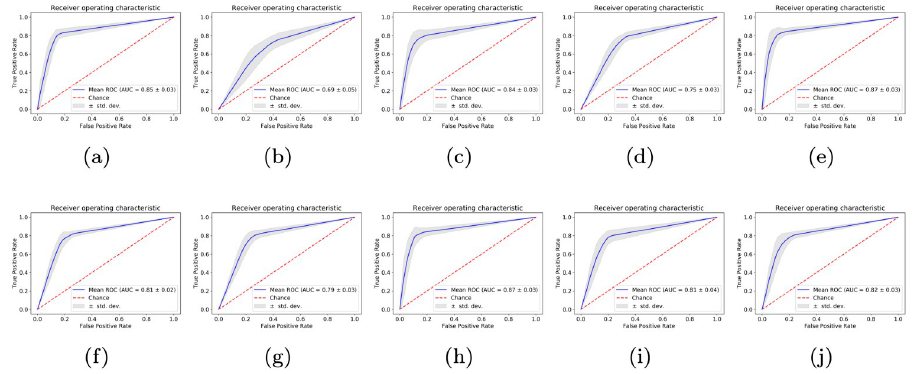
Fig 3. GBM signature in the DNA of blood-derived cells. ROC curves for pairwise classifiers built for comparing the mutation profiles of blood-derived DNA of GBM patients against (a) BLCA (b) HNSC (c) LUAD (d) LUSC (e) PAAD (f) PRAD (g) STAD (h) SKCM (i) THCA (j) LGG patients.